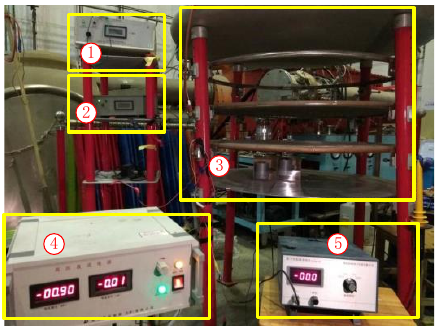
Figure 7. The measurement system in the laboratory. ① Corona voltage power supply ( Vc ); ② control voltage VA power supply ( Va ); ③ parallel-plate ion flow generator; ④ electrostatic field voltage power supply ( Vt ); and ⑤ a microgalvanometer.